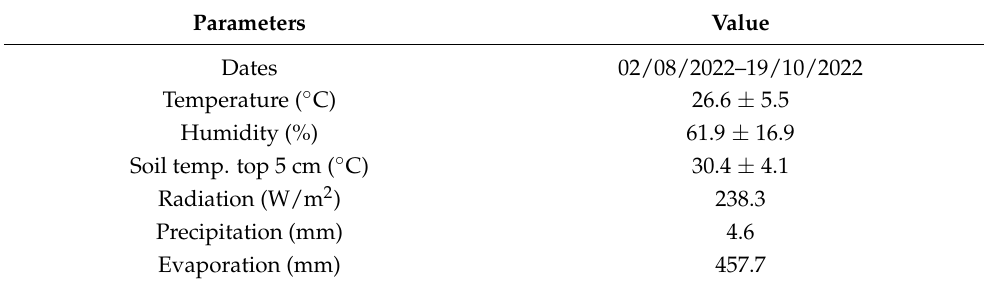
Table 3. Meteorological data for the 2022 semi-field experiments 1